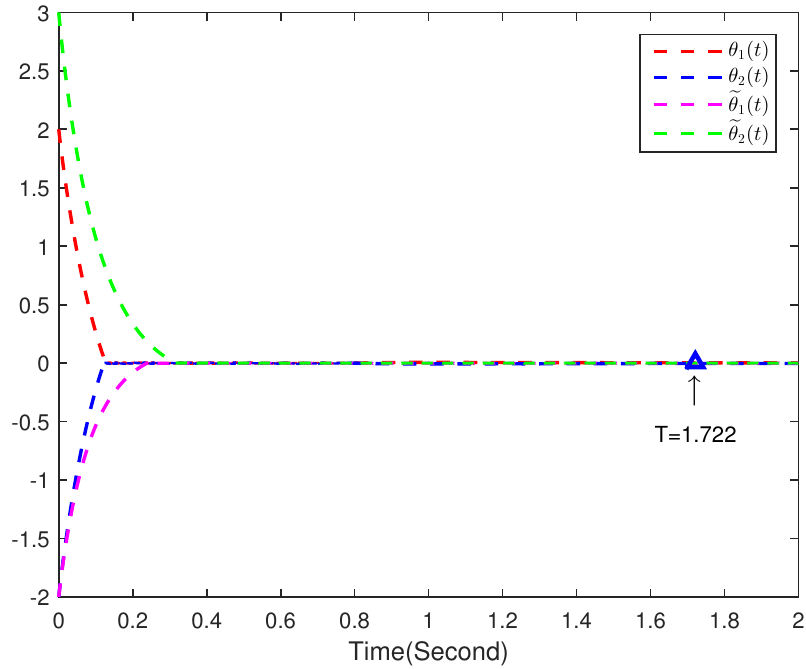
Figure 4. Synchronization error θ ( t ) and (cid:101) θ ( t ) between the drive-response system Example 2. Consider a two-dimensional FFINNs with piecewise activations and mixed